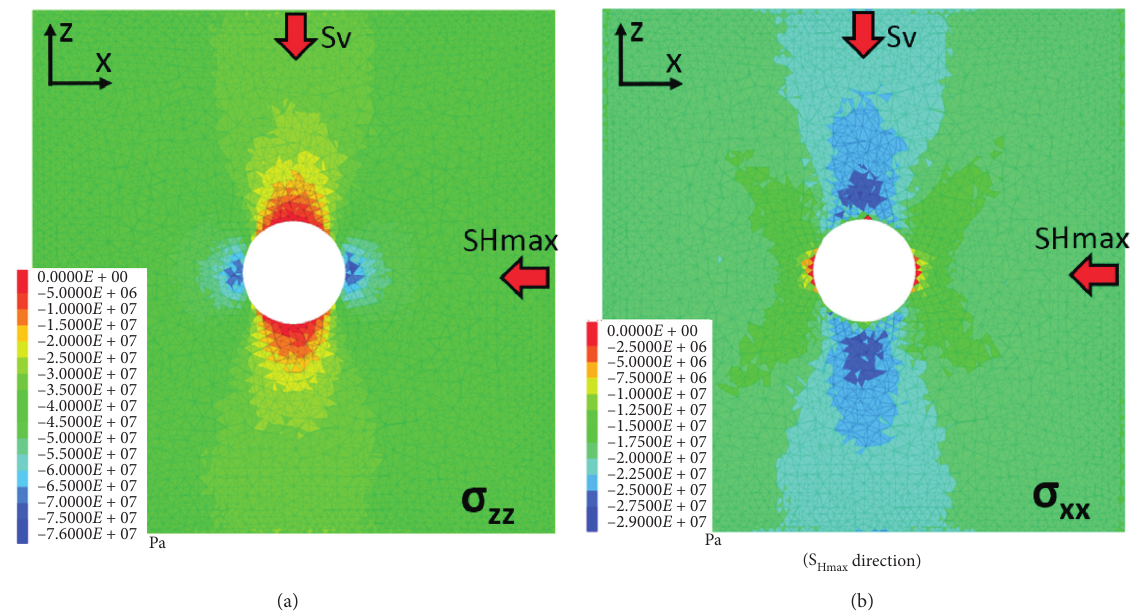
Figure 14: σ zz and σ xx in the plane perpendicular to the horizontal well ( XZ